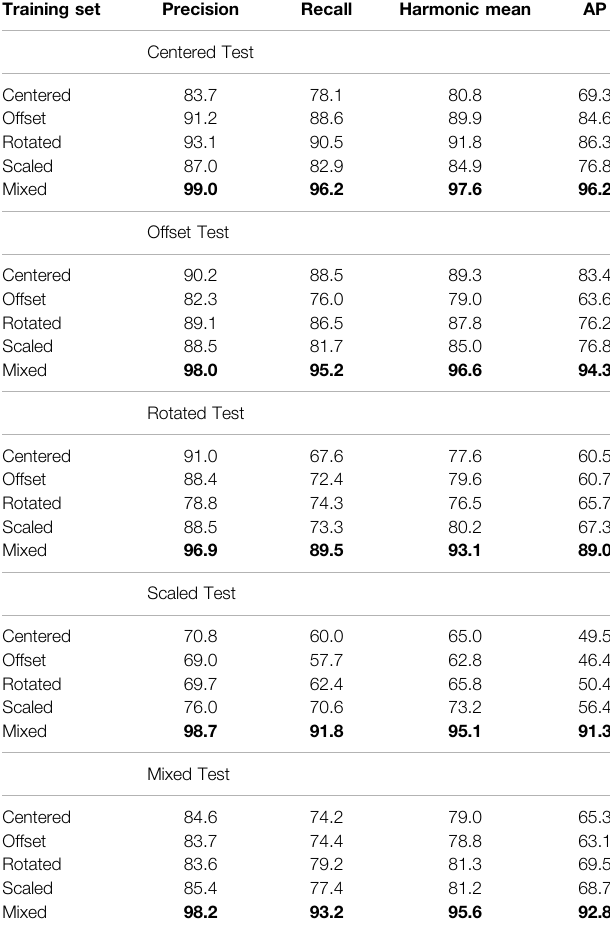
TABLE 5 | Evaluation results of models trained with augmented datasets. Each training subset was used to fi netune a single model, then each model was evaluated against each test subset for a total of 25 evaluation outputs. Bold text indicates the best performance in the set of tests with that model. Training